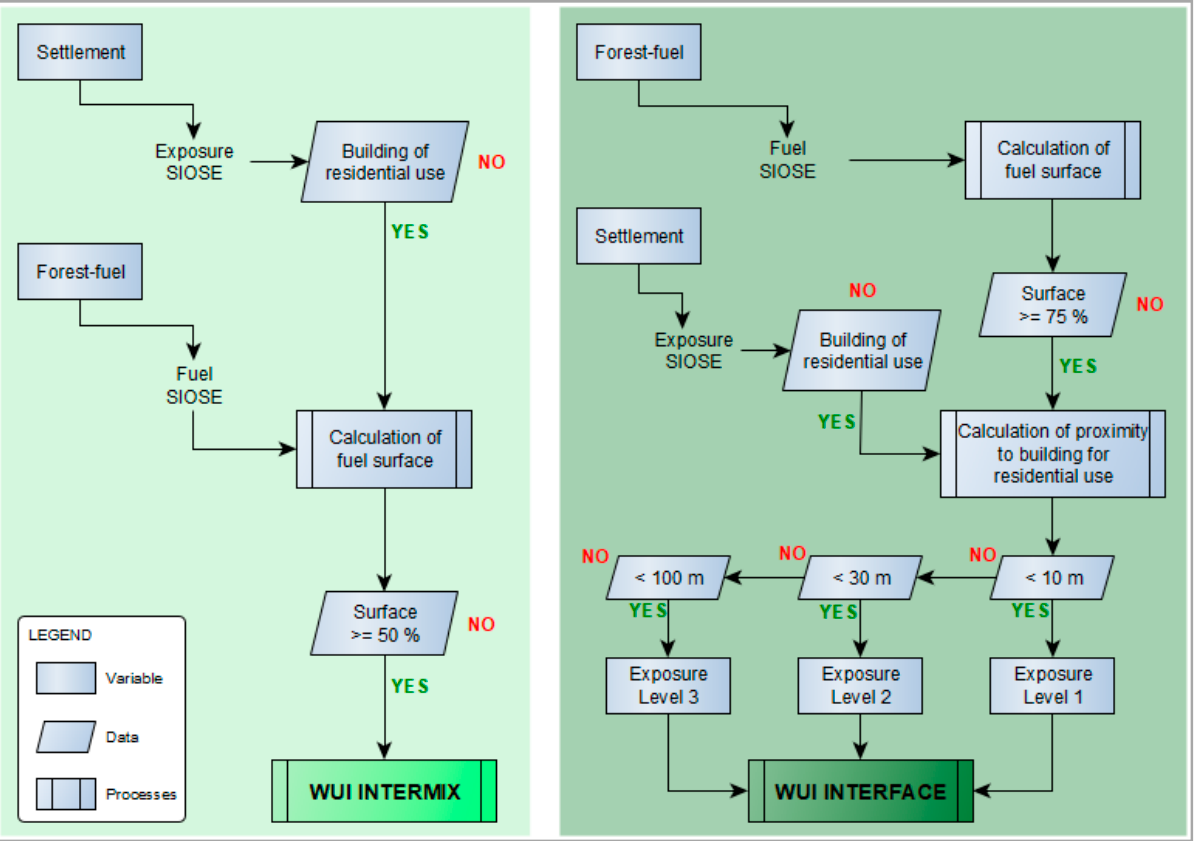
Figure 2 . Theoretical procedure to calculate intermix and interface. Source: Self made from Moreno et al. [24].